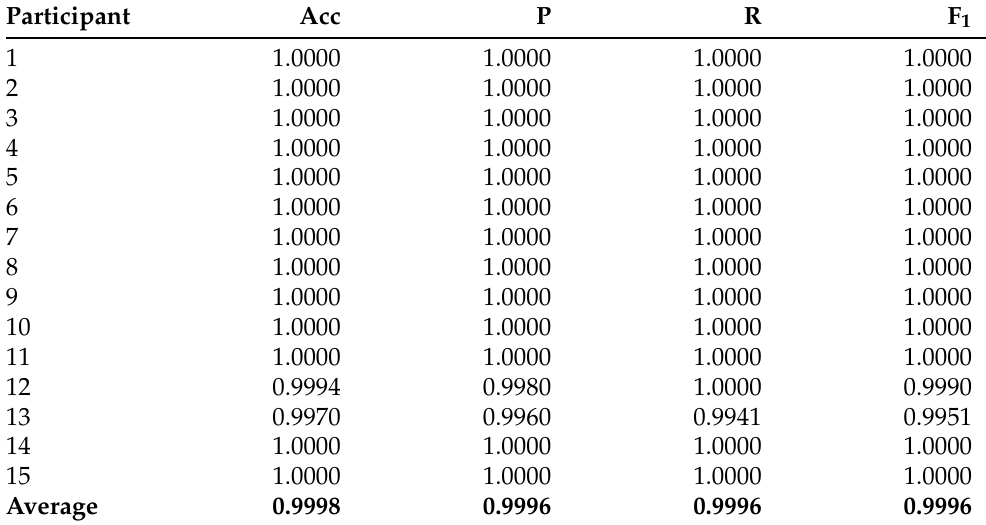
Table 4. Individual Learning